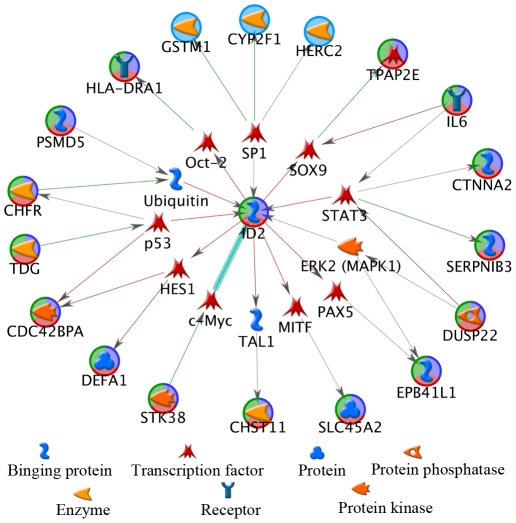
Biological network linking SNP PSF genes with methylation PSF genes.Nineteen gene products encoding various proteins are one node away from ID2, mostly connected via a transcription factor. Among these are the 3 genes in the SNP PSF (HERC2, CTNNA2 and SLC45A2) and 16 genes in the methylation PSF.